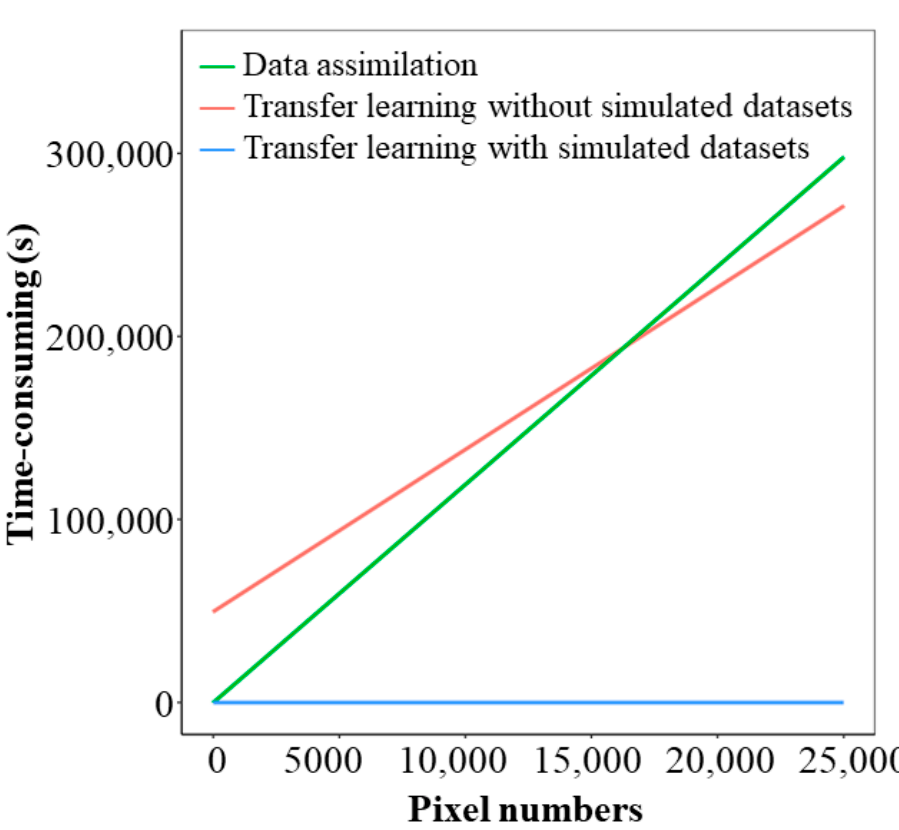
Figure 8. Comparison of computational efficiency between data assimilation and transfer learning algorithms. Computer configuration: Lenovo Legion R7000 2021 CPU R7-5800H @ 3.20 Hz and 16G random-access memory.